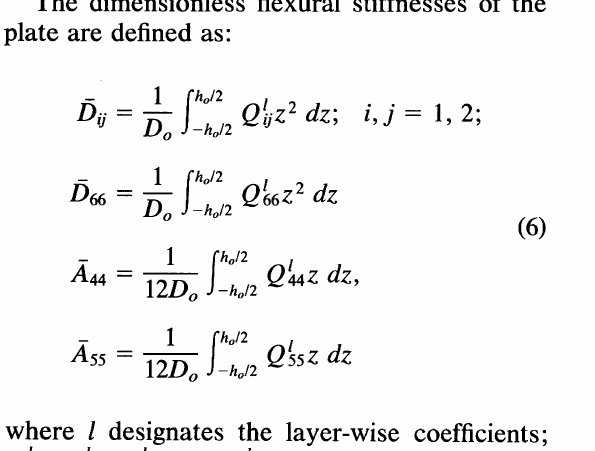
Table 1. Plane Stress Reduced Stiffness and Shear Stiffness Coefficients in Terms of Elastic Constants of Orthotropic Ply